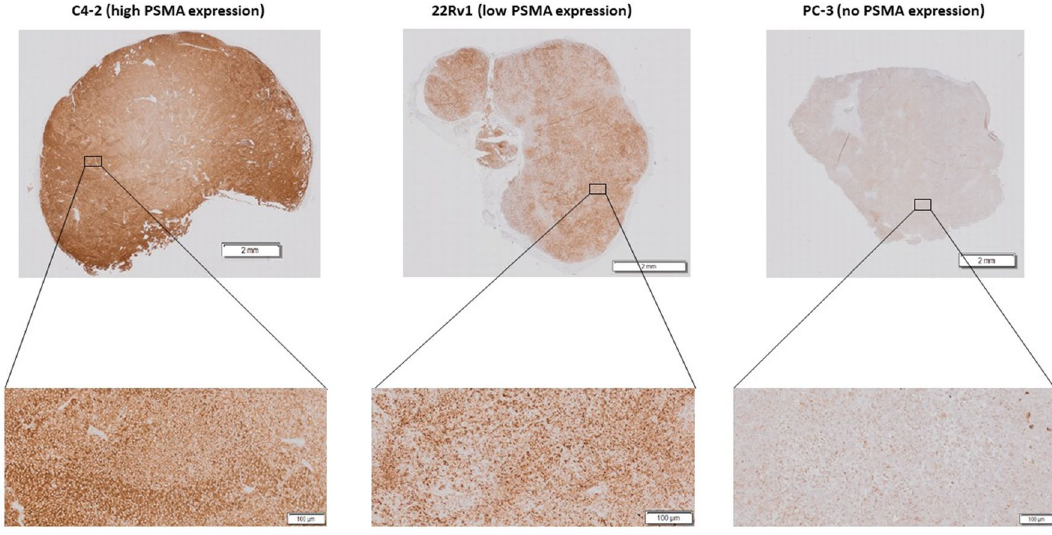
Figure 1. Immunohistochemical staining of tumor tissues of C4-2, 22Rv1 and PC-3 confirming the differences in PSMA